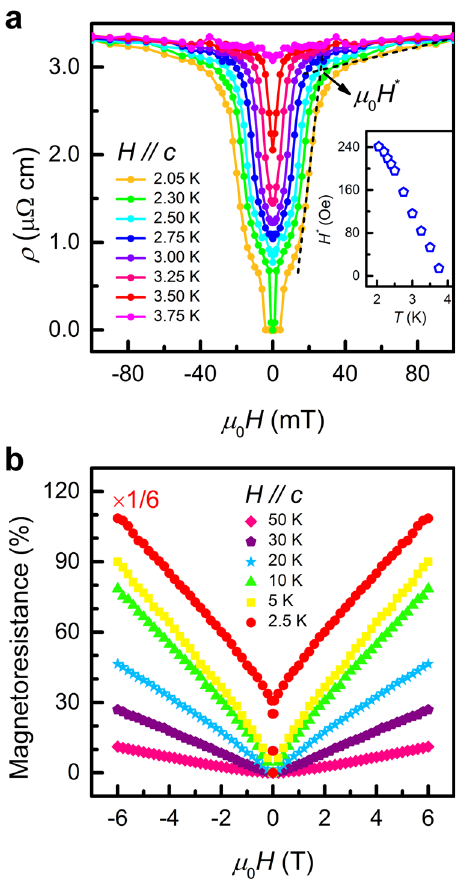
Fig. 6 Magnetoresistance of AuSn 4 . a Resistivity with applied fi elds parallel to the crystal c -axis at various temperatures. The intersection of two dashed lines denotes the determination of the crossover fi eld H *. The inset shows the temperature dependence of H *, as obtained from data in a . b Non-saturating MR( H ) for temperature up to 50 K and fi eld of up to 6 T. Note the drastic increase in magnetoresistance at 2.5 K plotted with a contracted scale of MR( H ) × 1/6. Also note that the data show a duplicate result of magnetoresistance in positive and negative fi elds, as described in the